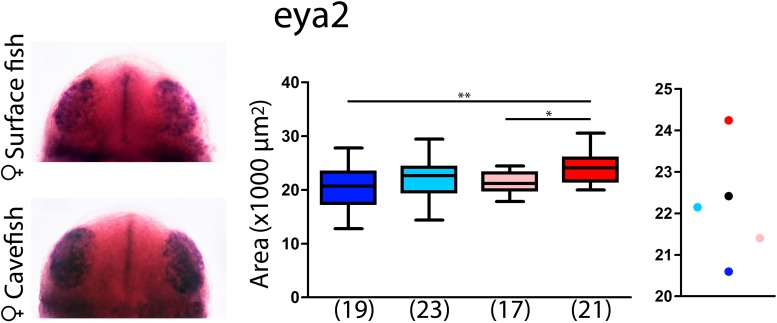
Maternal effect on the size of the developing olfactory epithelium.Expression of eya2 in HybSF (left, on top) and HybCF (left, on bottom) at 24 hpf. Quantification of the size of the eya2 expression domain in the olfactory placodes (center) and the corresponding plot of means distribution (right). Embryos in panels (A–D) were dissected and mounted in ventral view, anterior upwards. Embryos in panels (E–H) are whole-mounted embryos in lateral view anterior to the left (E); in dorsal view, anterior upwards (G); or in frontal view, dorsal upwards (H). Kruskal-Wallis tests with Dunn’s post-test were performed.